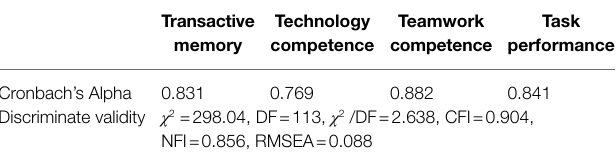
TABLE 2 | Reliability and validity of